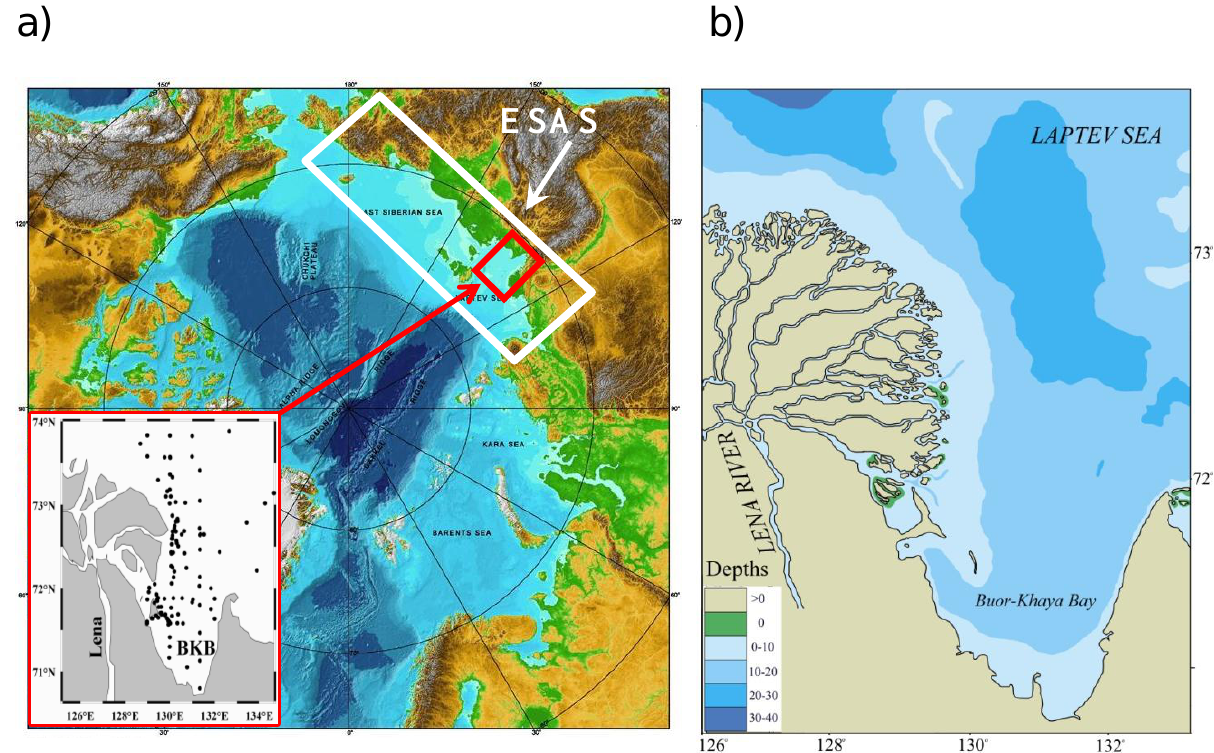
Fig. 1. (a) Study area: position of the Buor-Khaya Bay (BKB) of the Laptev Sea in the ESAS. Study area coverage with oceanological stations (black dots) is shown in the lower left corner (red rectangle); (b) bathymetry of the BKB